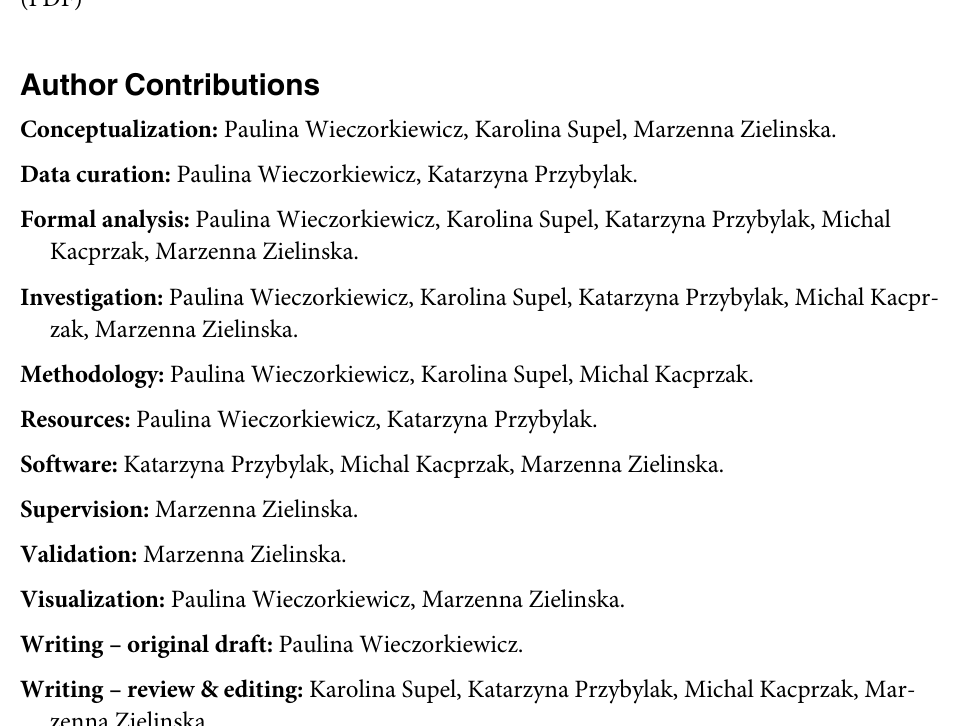
S1 Table. Minimal data